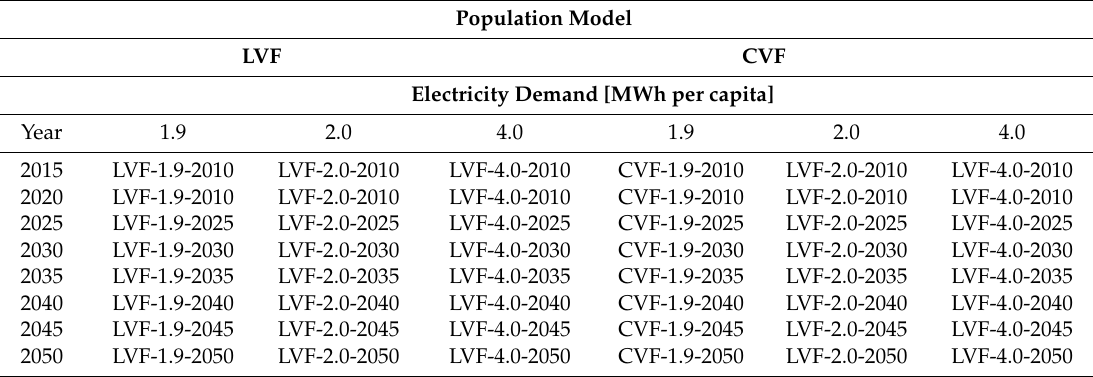
Table 1. Matrix of described